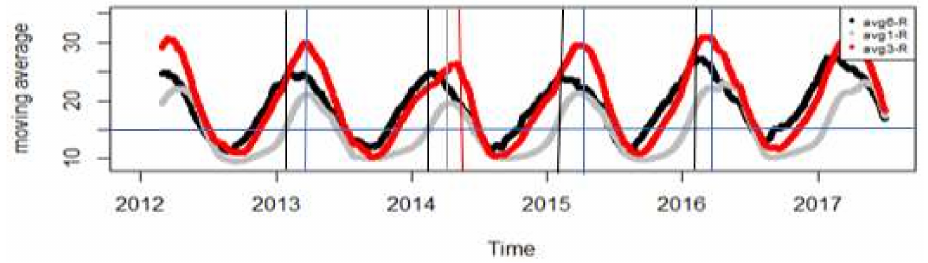
Figure 15. Avg5-R, avg1-R, and avg3-R 60-day moving averages ( ◦ C).